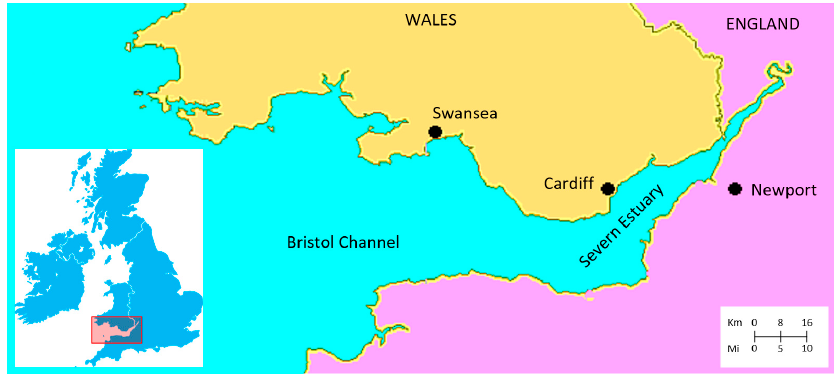
Figure 8. Area surrounding the Severn Estuary and the Bristol Channel in south-west UK.